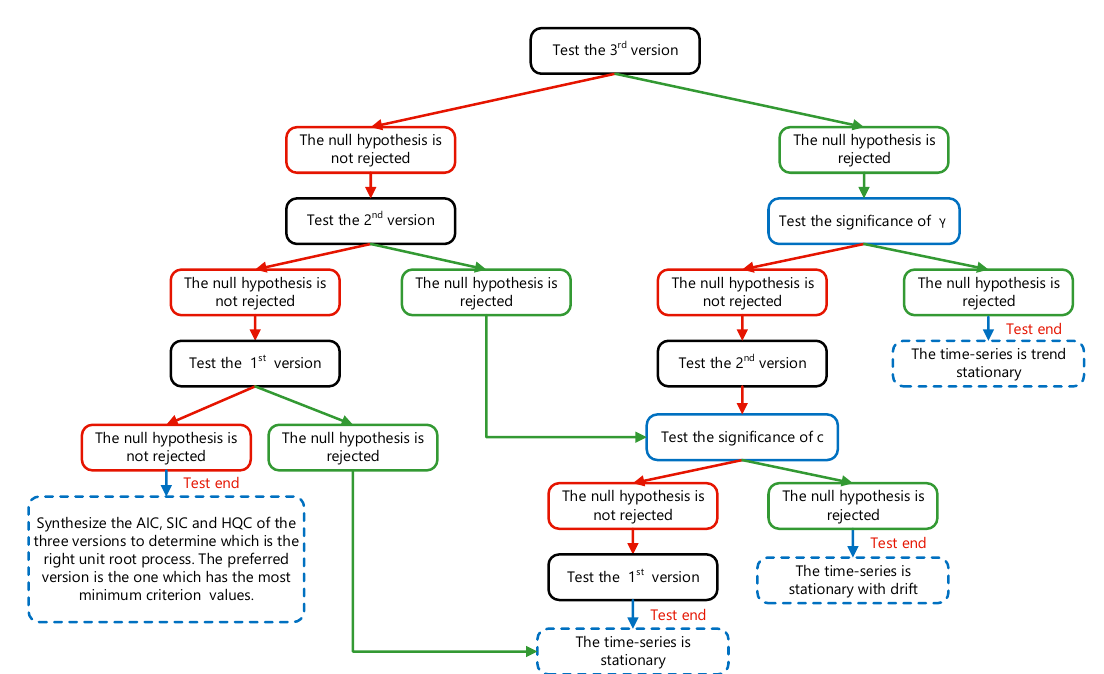
Figure 2. The flow chart of the augmented Dicky – Fuller (ADF) test.